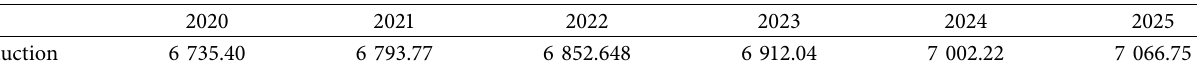
Table 5: Prediction of grain yield in Henan province (unit: 10 4 tons).